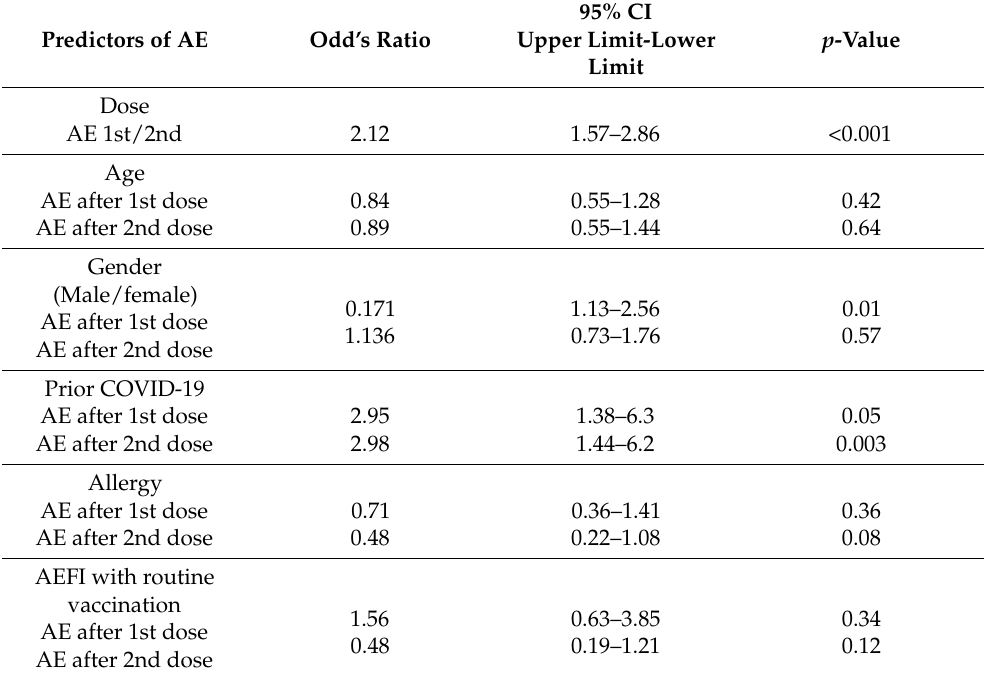
Table 3. Description of adverse event (AE)-related variables after first and second dose of m-RNA COVID-19 vaccine in group B (12–17